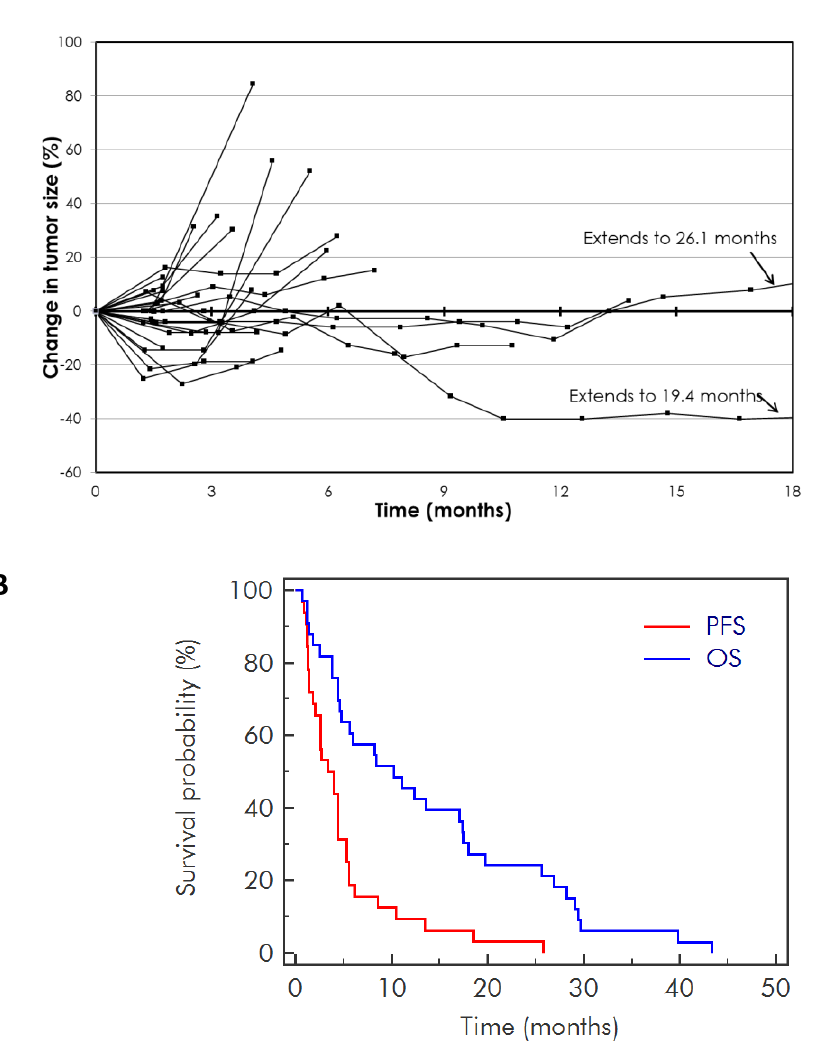
Figure 1. Survival of patients with advanced pancreatic cancer receiving pelareorep in combination with gemcitabine. ( A ) Spider plot showing the change in tumor size at each 6 week time point for 29 patients; ( B ) progression free survival and overall survival for all patients on study.